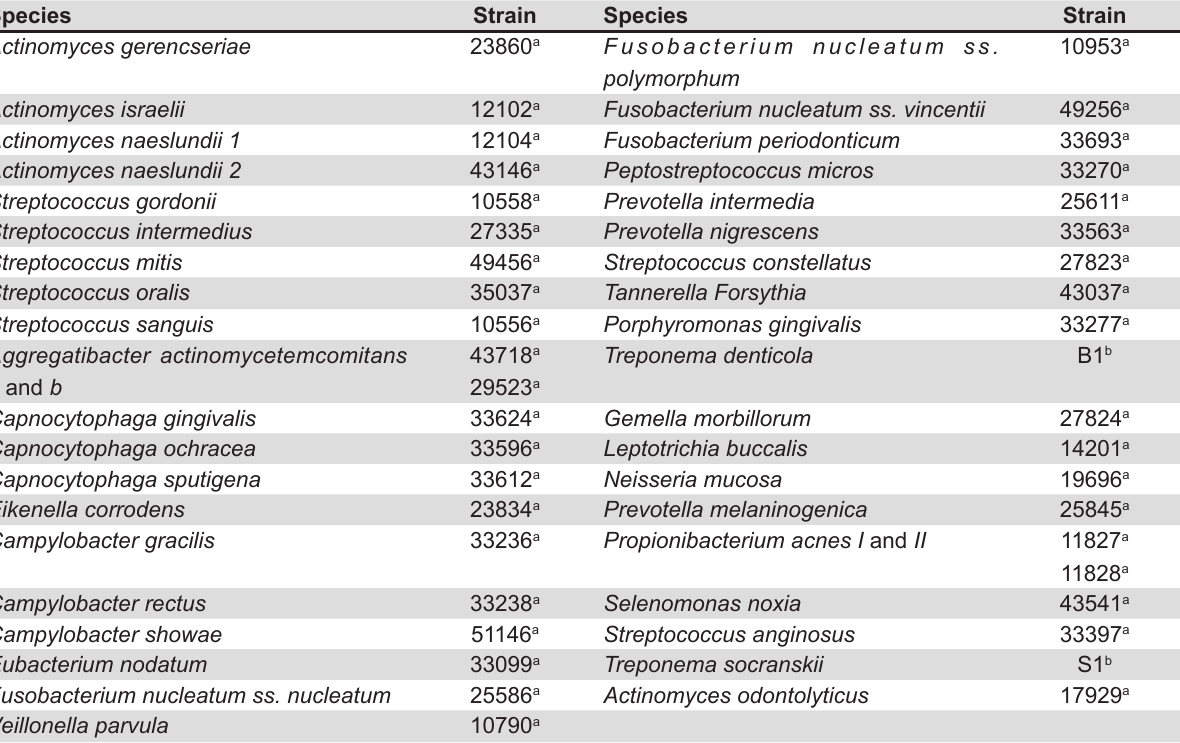
Table 1- Bacterial species investigated by checkerboard DNA-DNA hybridization